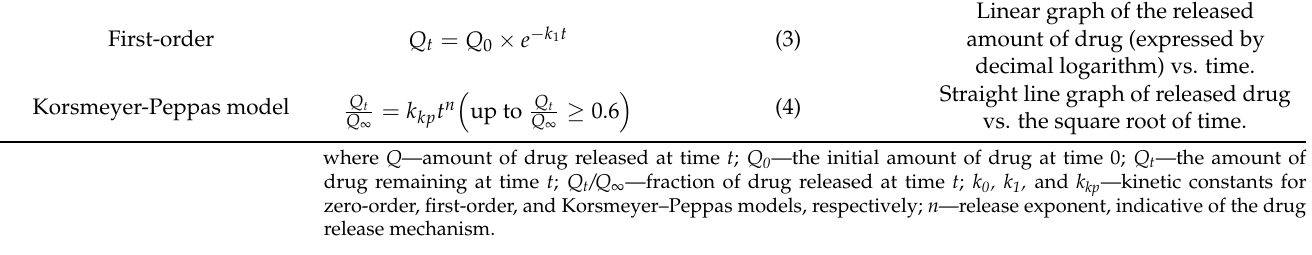
Table 2. Mathematical models of drug release profiles. Model Equations [29,30] Graph Zero-order